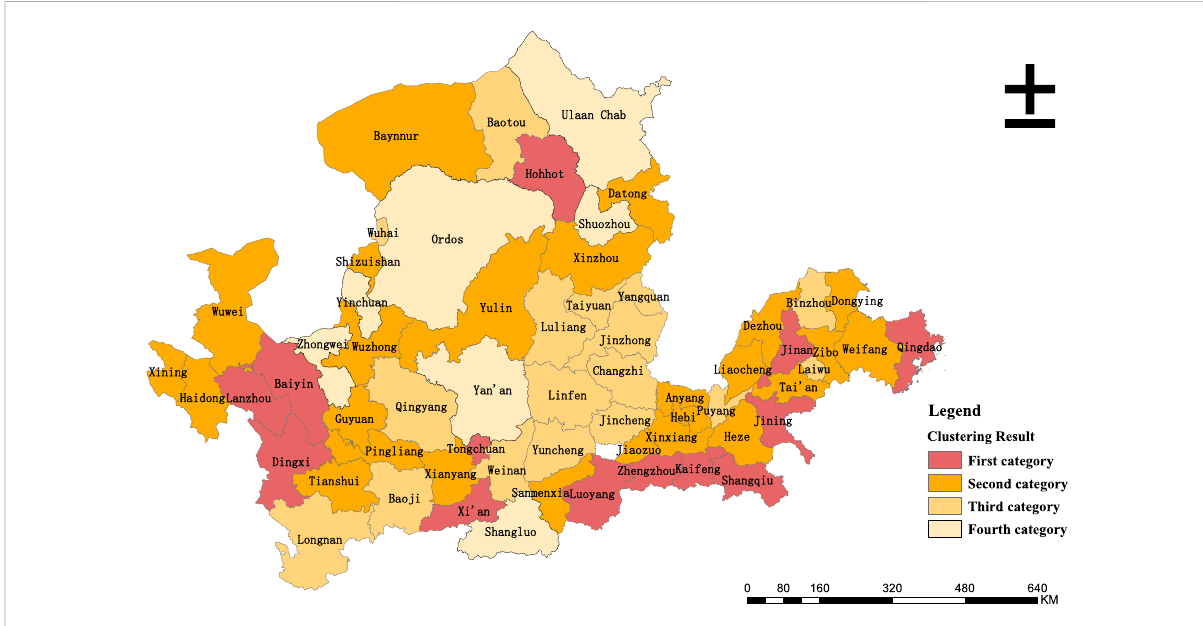
FIGURE 2 Spatial variation of the level of HQD of 62 cities in the YRB in 2020. Note: The sources of the vector diagram of the YRB come from the